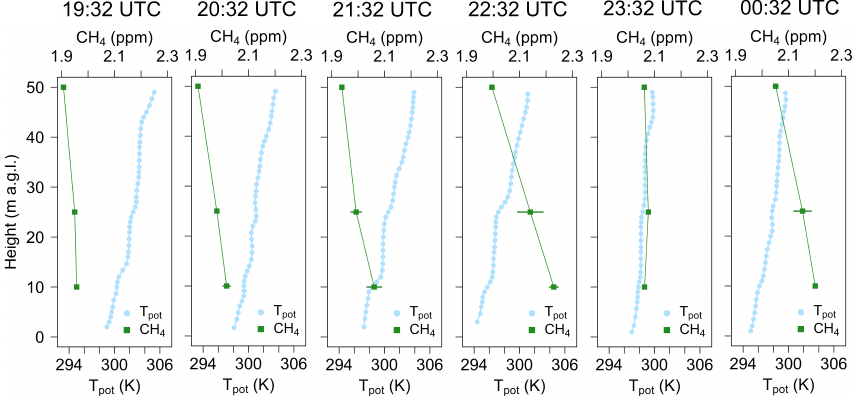
Figure 8. Vertical potential temperature ( T pot ) profiles in blue and methane concentrations in green over 6h from 19:32UTC (left) to 00:32UTC (right) on the night of 21–22 July 2015. This corresponds to 21:32 to 02:32CEST (UTC + 2). Air temperature was measured with the thermocouple (ascent data only) and T pot was calculated with the onboard pressure data from the autopilot. T pot was averaged at hovering levels and smoothed with a moving average (3s). Error bars of methane concentration show the standard deviation for each measurement averaged over 60s. A standard deviation of 0.01ppm or less cannot be shown because the size of the data point exceeds the error bar.